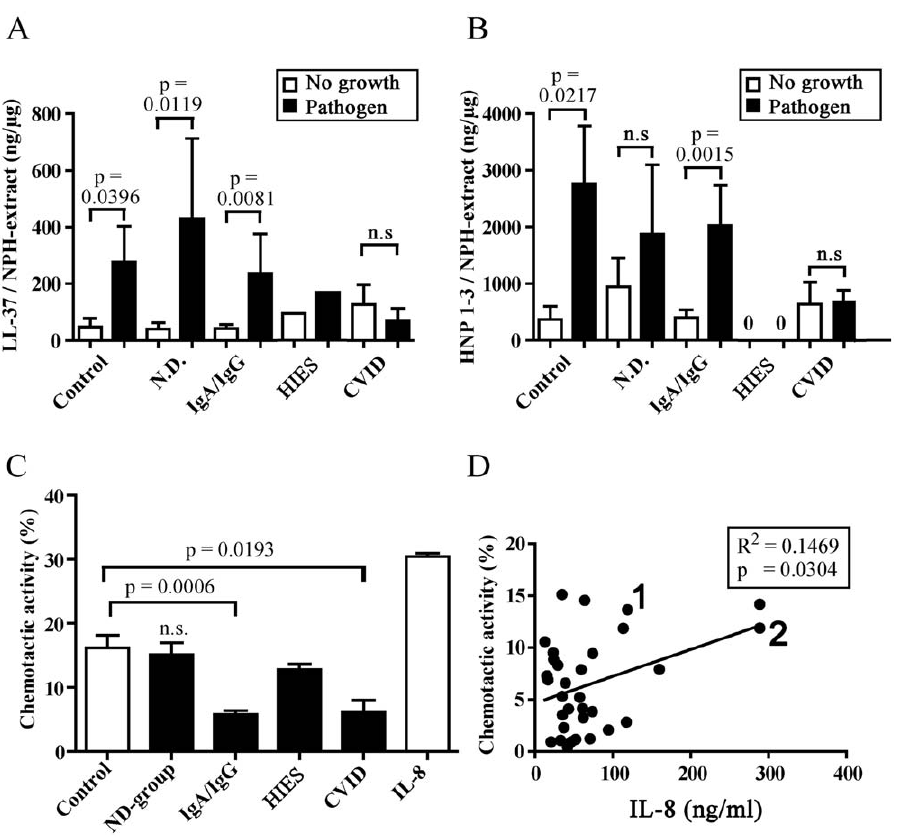
Figure 3. AMP response and chemotaxis in relation to diagnosis. AMP levels were studied according to diagnosis and presence of bacterial pathogens. ‘‘No growth’’ designates negative bacterial cultures and ‘‘Pathogen’’ designates growth of a primary bacterial pathogen (A and B). The number of samples included (control, ND, IgA/IgG, HIES, and CVID respectively with and without growth) are n=7, 3, 11, 9, 27, 14, 1,1, 6, 4 (A), n=7, 2, 11, 10, 28, 13, 1,1, 6, 4 (B). The chemotactic capacity was determined for samples from each diagnostic group and is expressed as percent migrated neutrophils (C). The numbers of samples in C are: n=5, 10, 44, 2, 10, 7. Error bars depict the SEM of a sample. Levels of IL-8 in nasal fluid (n=32) were plotted against the chemotactic index and a weak positive correlation was found (p=0.03, R 2 =0.14) (D). HIES-patients 1 and 2 are marked ‘‘1’’ and